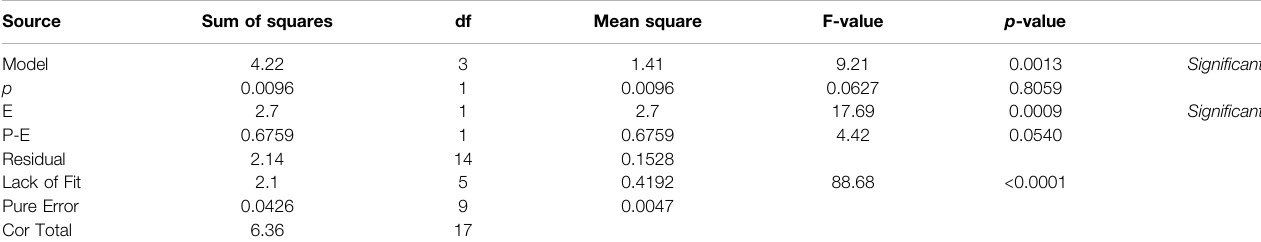
TABLE 2 | 2FI assessment for the effect of pressure ( p ) and decompression speed (E) on VD3 measurements. Source